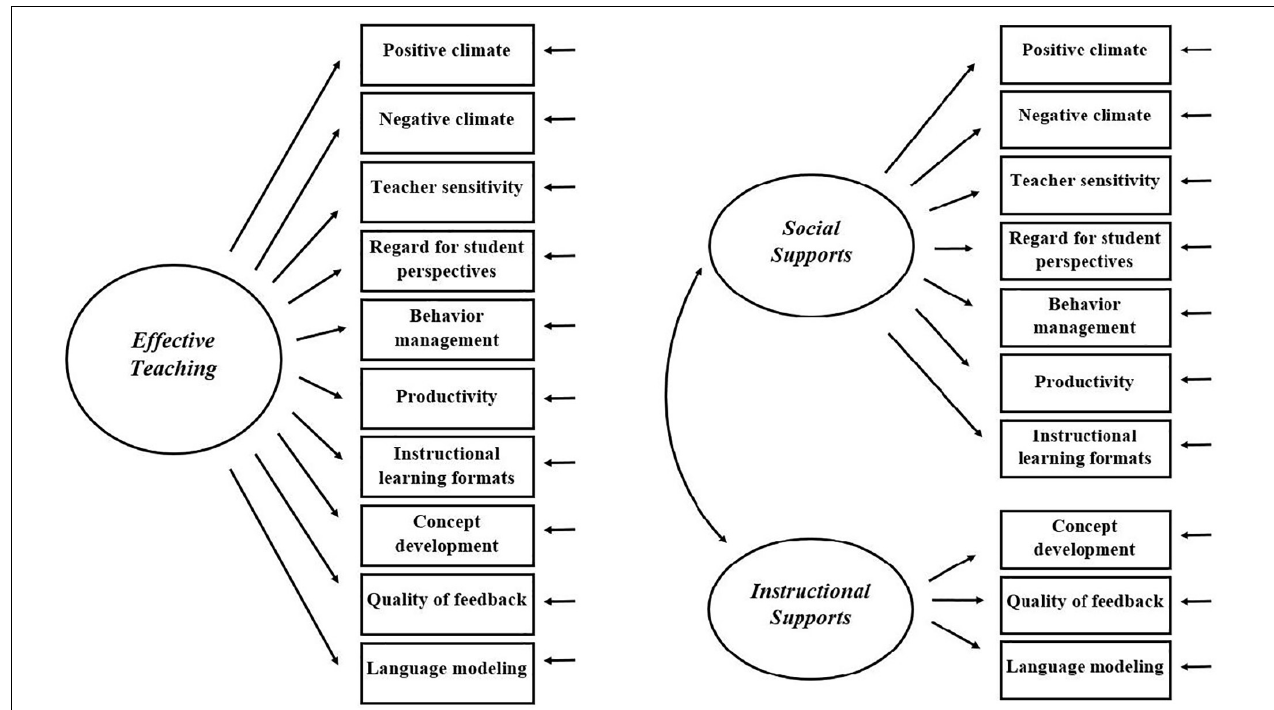
FIGURE 2 | Alternative CLASS Pre-K one-factor (left) , and two-factor model (right) (Hamre et al.,